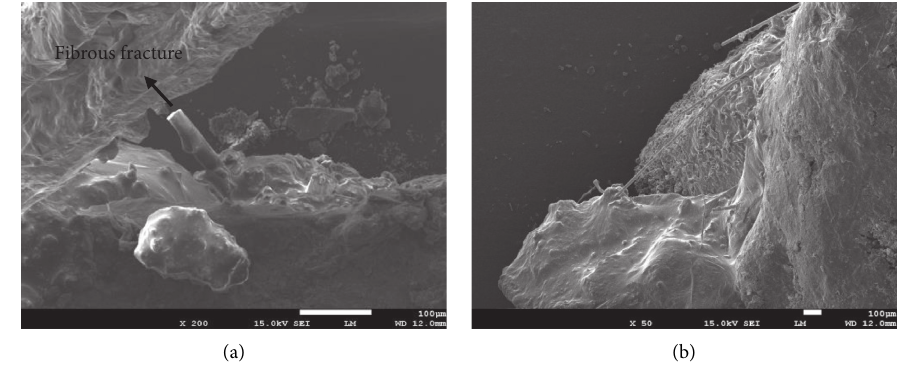
Figure 16: Fracture of basalt fiber drainage asphalt